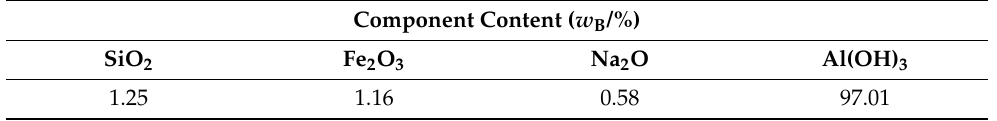
Table 2. Components of industrial aluminum